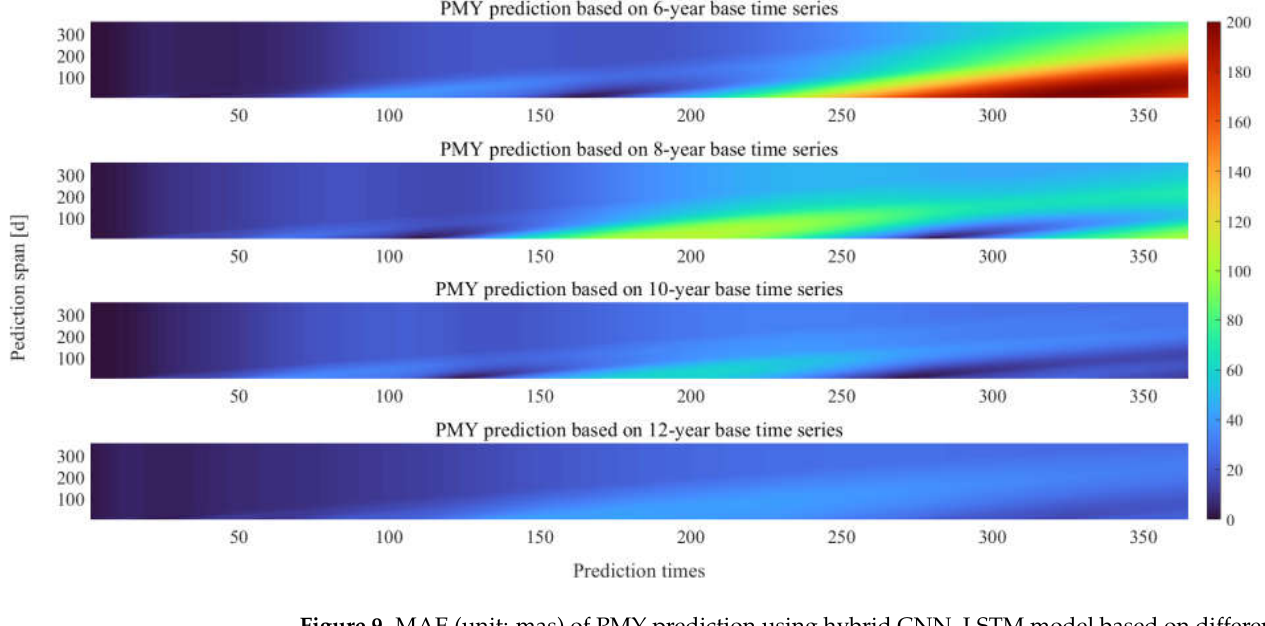
Figure 8. MAE (unit: mas) of PMX prediction using hybrid CNN–LSTM model based on different base time series.